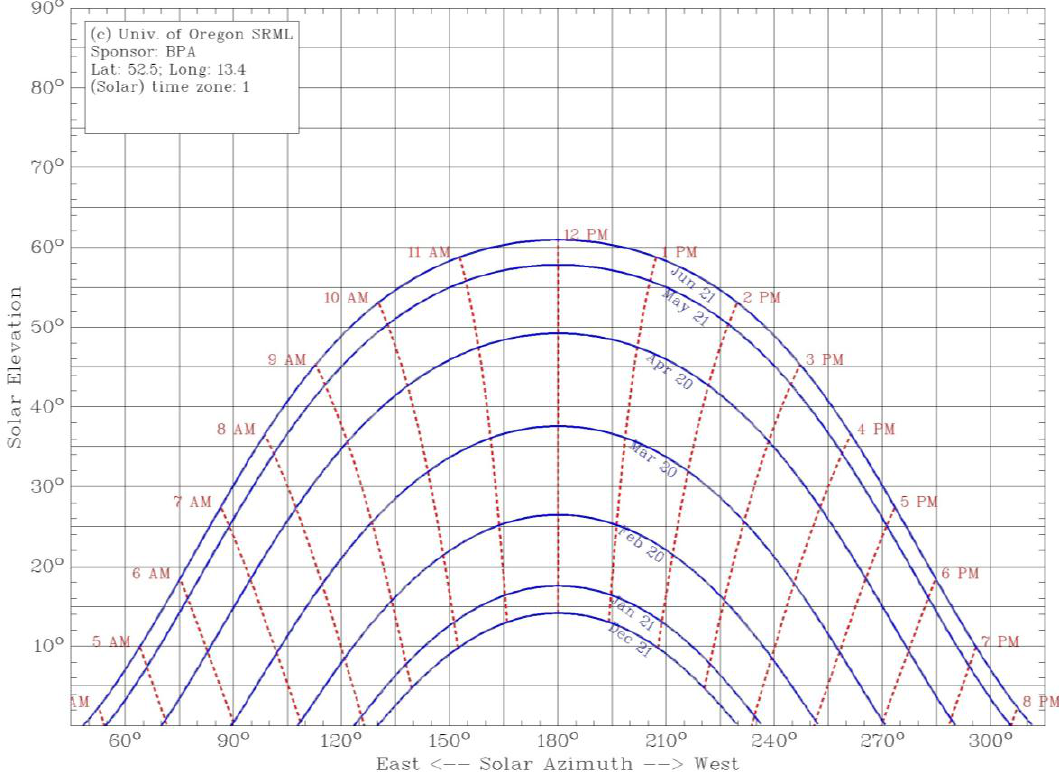
Figure 7. Solar position Diagram for Berlin, Germany (52.5° N 13.4° E) [69].